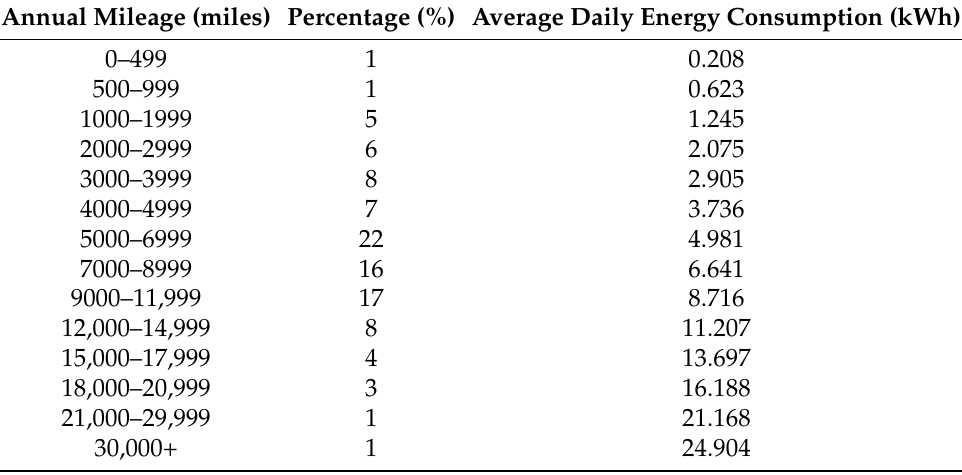
Table 1. Annual mileage of cars in England and energy